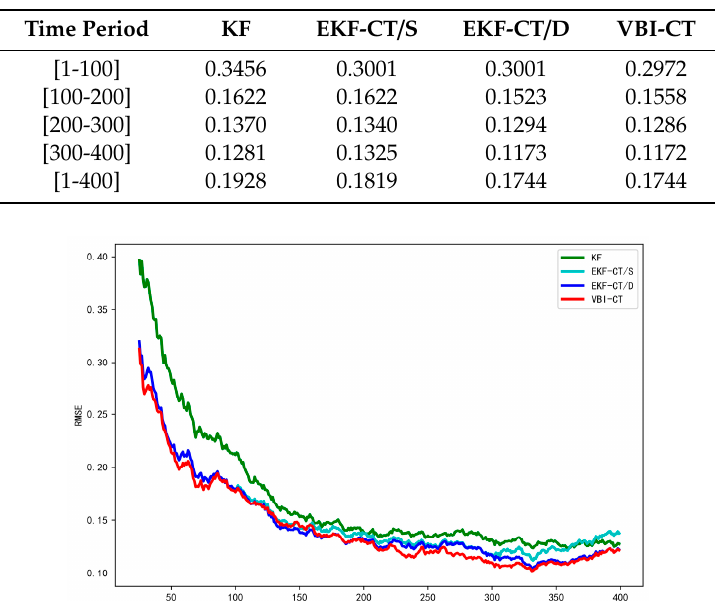
Table 6. Total execution time (s) of different algorithms.